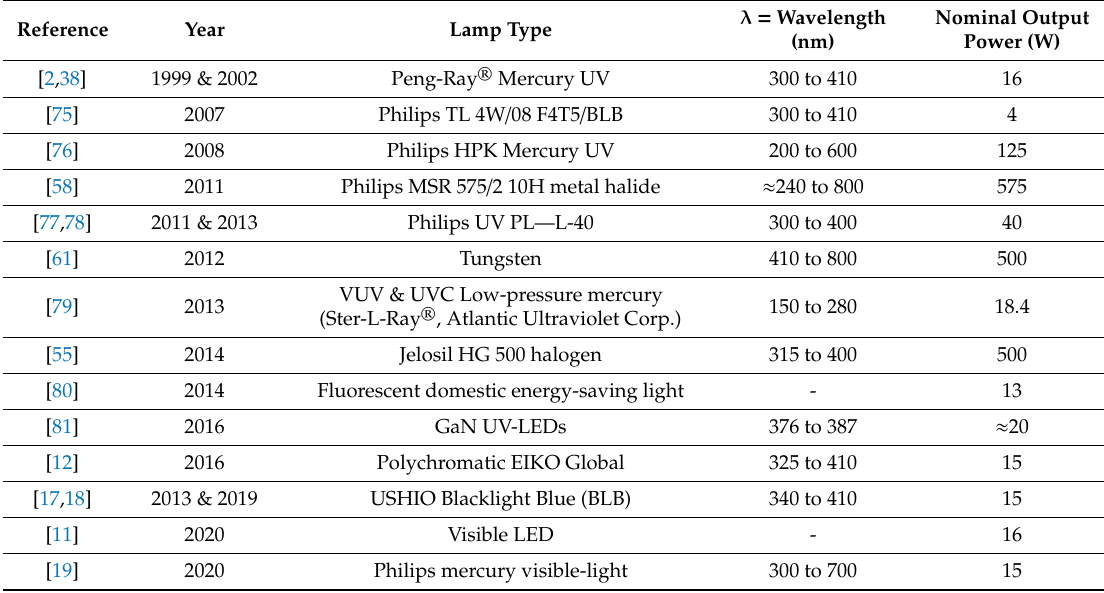
Table 2. Di ff erent types of light sources employed in photocatalytic reactors for air, water and hydrogen production